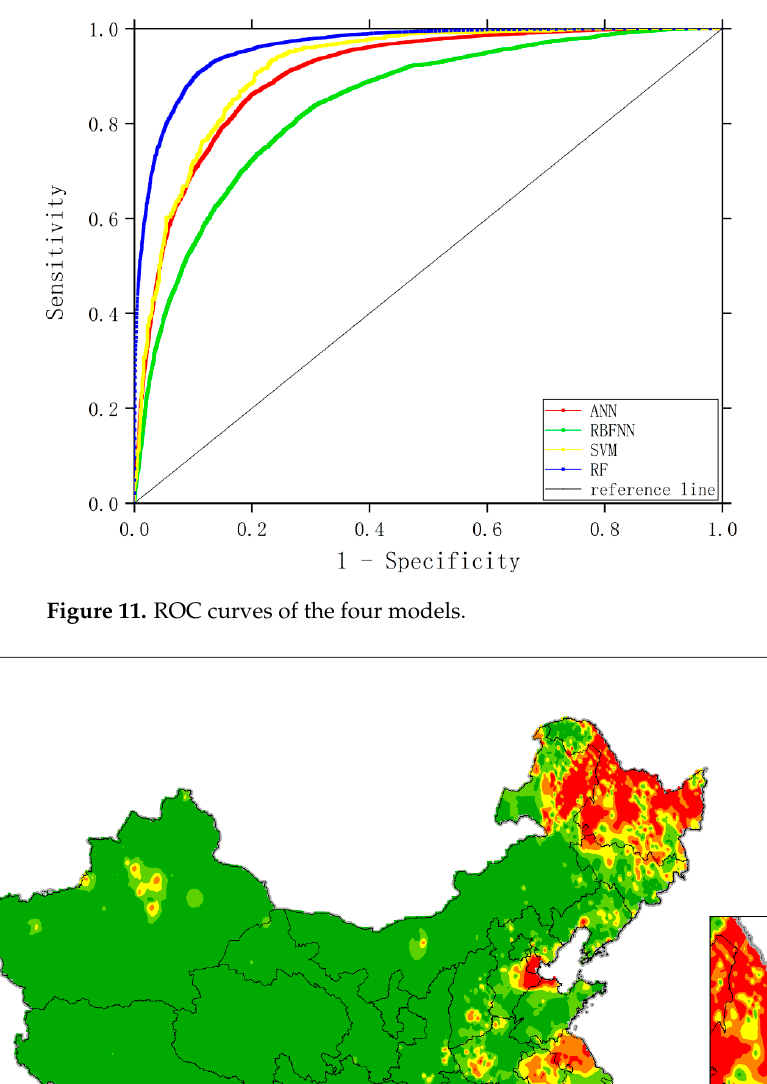
Table 6. Evaluation results of the four models.